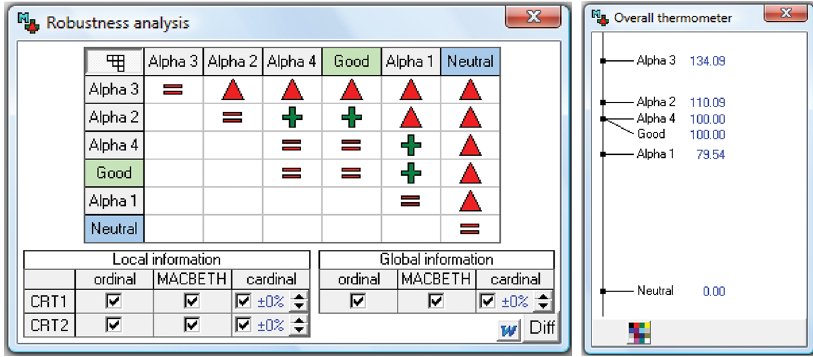
Fig. 7. Robustness analysis and overall